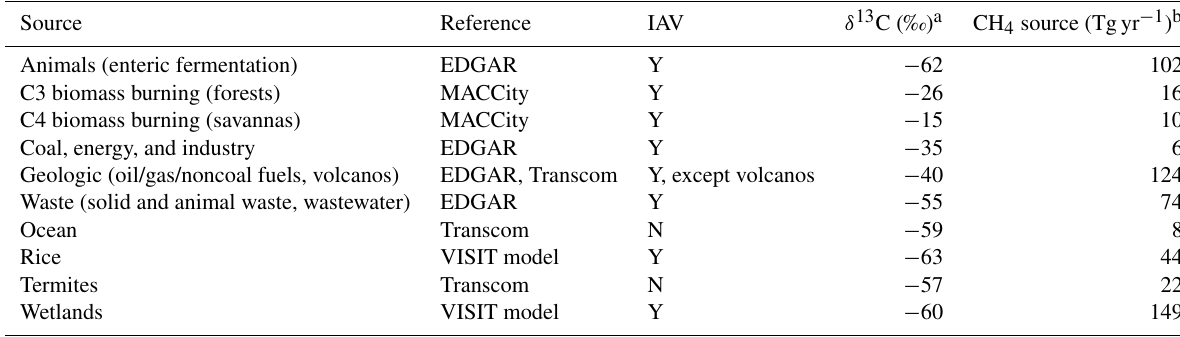
Table 1. Emission source references, description of interannual variability (IAV), and δ 13 C values.